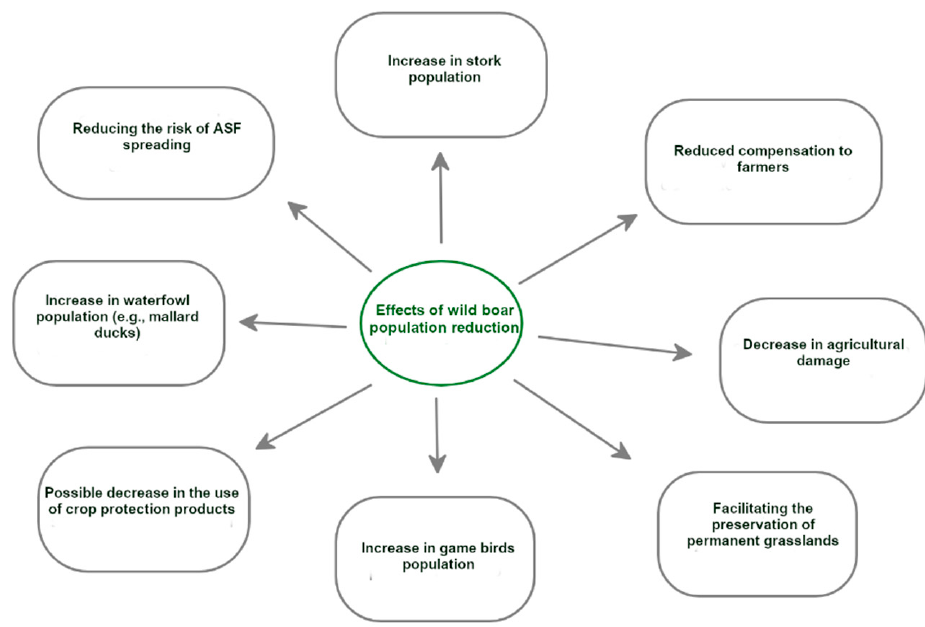
Figure 3. Effects of wild boar population reduction.